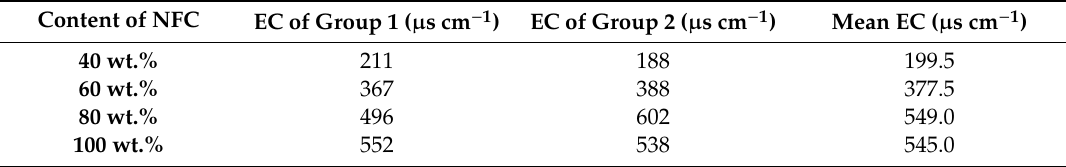
Table 2. Electrical conductivity (EC) of the suspension with di ff erent NFC